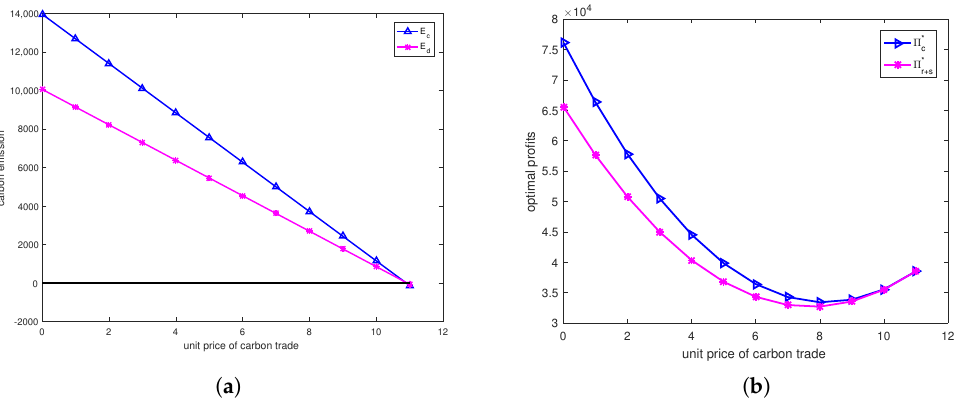
Figure 3. ( a ) The effects of unit price of carbon trade on emission. ( b ) The effects of unit price of carbon trade on